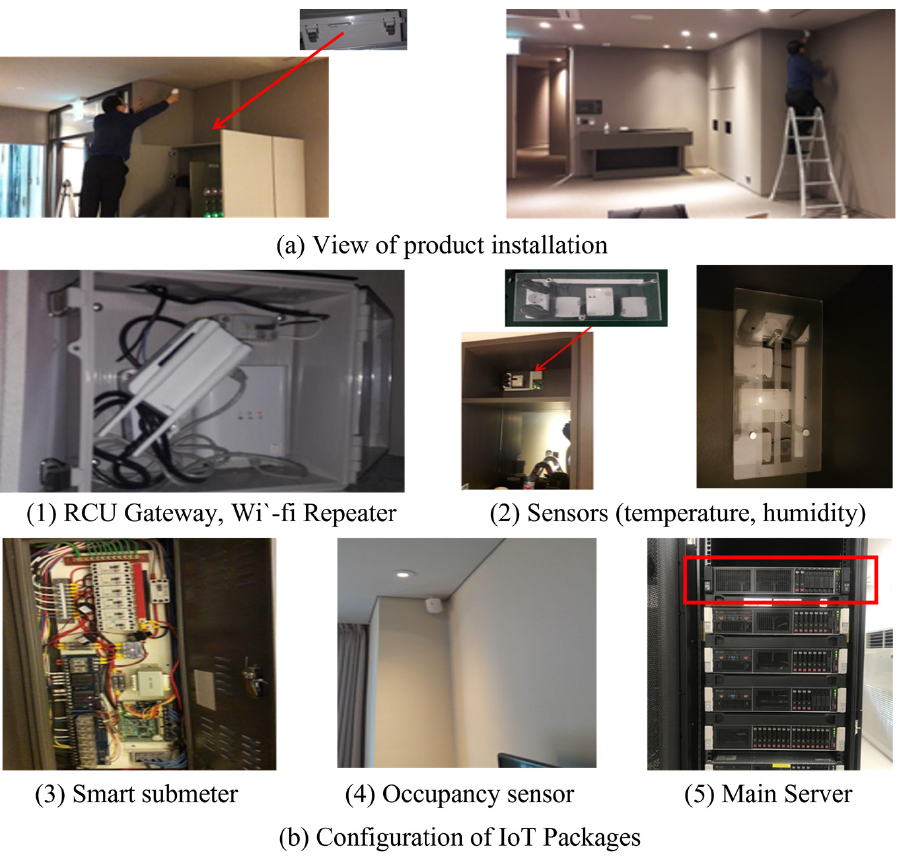
Figure 5. Sensor installation and device locations in the building.